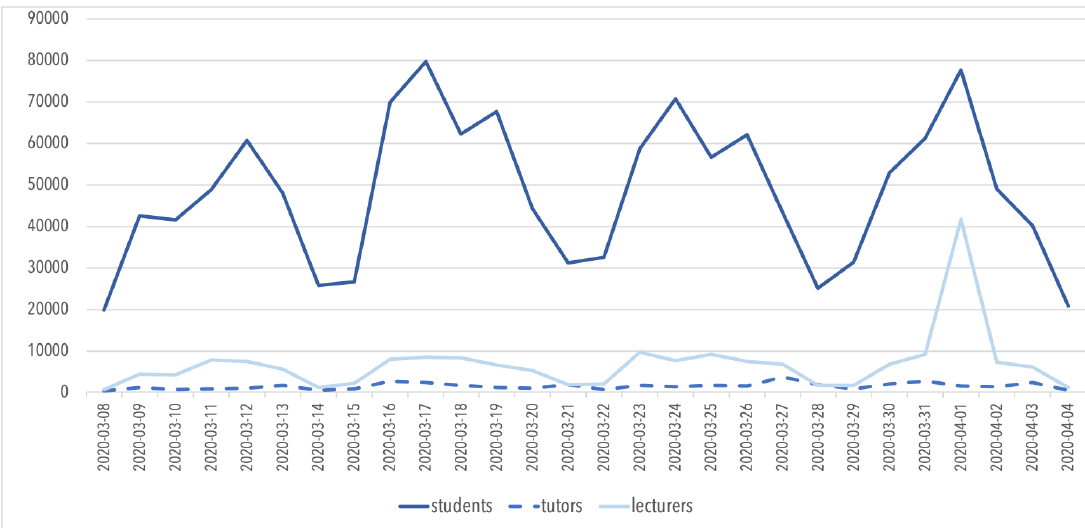
Figure 5. Sum of activities in TeachCenter for different user groups per day from 8 th of March 2020 to